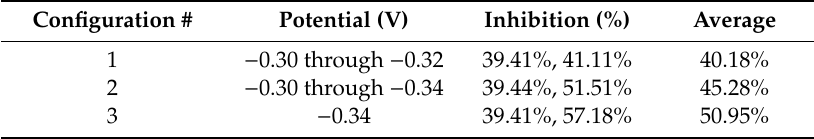
Table 1. Average percentage of malathion inhibition of three di ff erent